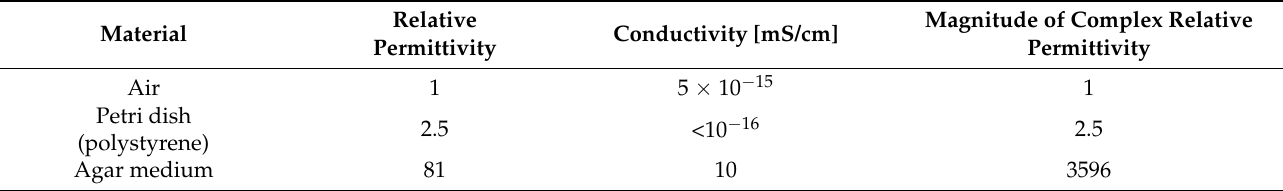
Table 2. Magnitude of complex relative permittivity for